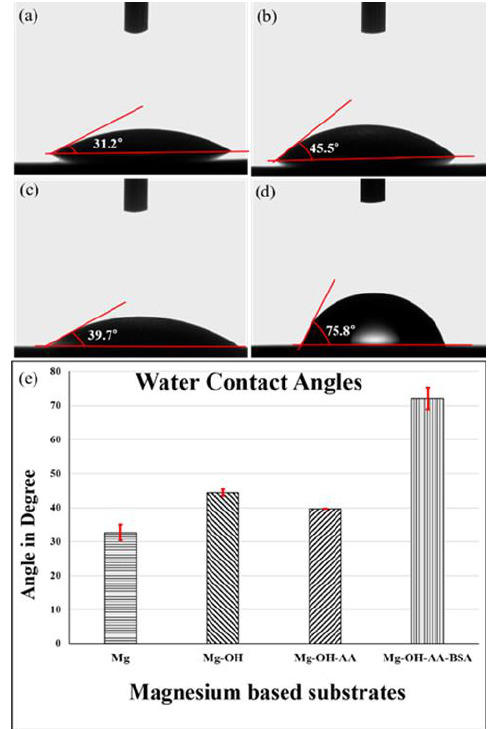
Figure 5. Water contact angle values of the samples including ( a ) pure Mg, ( b ) Mg-OH, ( c ) Mg-OH-AA, and ( d ) Mg-OH-AA-BSA at RT. ( e ) histogram showing the average contact angle value of each substrate (n = 3). The WAC value of each sample was obtained before potentiodynamic corrosion